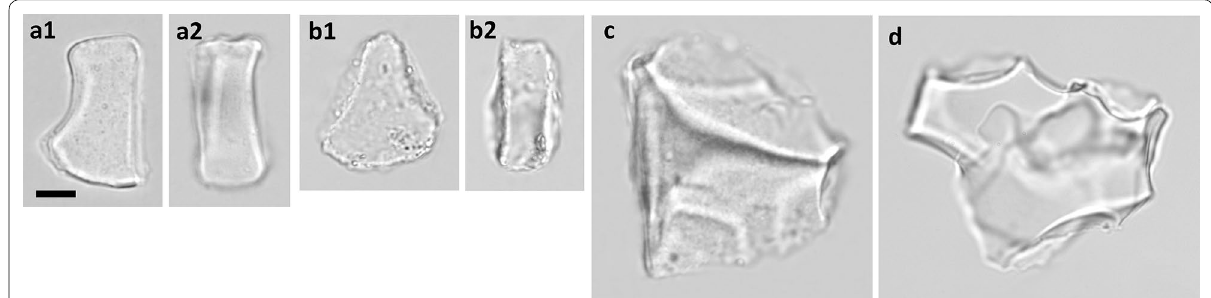
Fig. 8 Bulliform phytoliths of subfamily Pooideae. a B. kawakamii ; b T. spicatum var. formosanum ; c T. aestivum ; d A. sativa . 1 , end view; 2 , lateral view. Bar 10 μm, all pictures are in the same